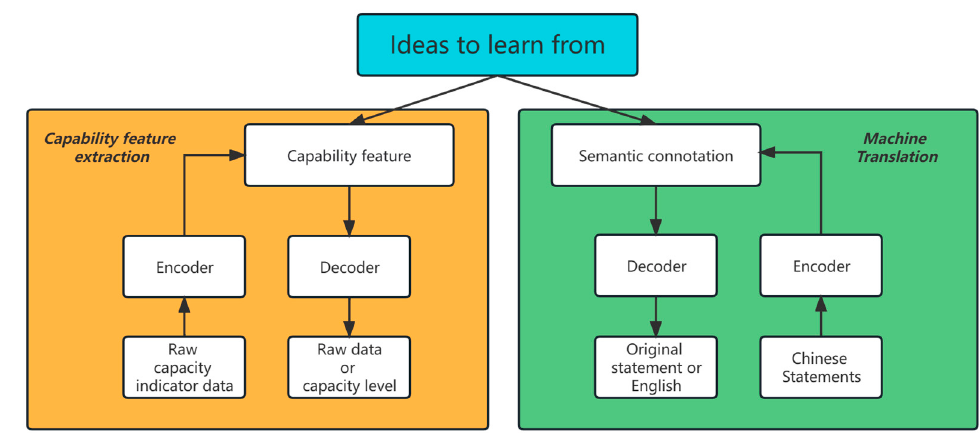
Figure 1. Feature extraction